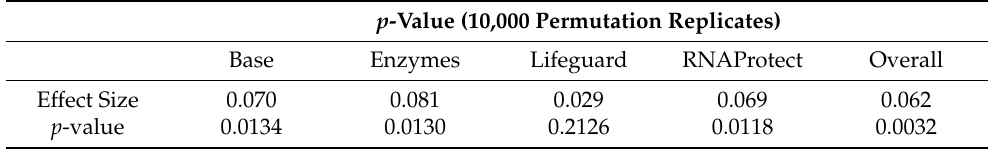
Table 3. Tests of effect of Snus Matrix on bias parameters for four extraction protocols. p -Value (10,000 Permutation Replicates) Base Enzymes Lifeguard RNAProtect